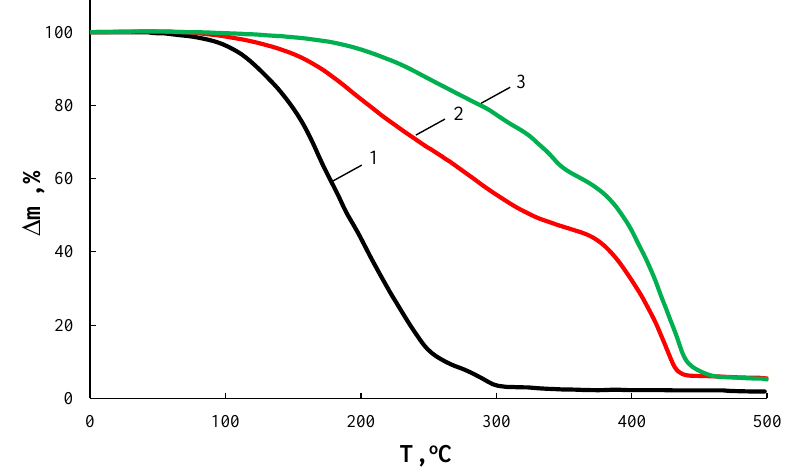
Table 1. Characteristics of thermo-oxidative stability of AEBA-MEG, AEBA-DEG AEBA-TEG for the heating rate of 10 °C/min.